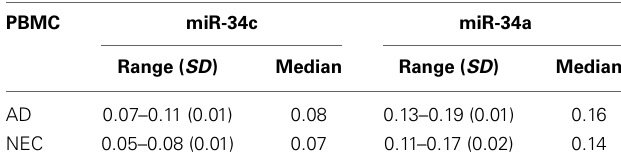
Table 6 | 1/deltaCt level ranges, with standard deviation (SD) and median, of microRNAs in PBMC from Alzheimer’s disease (AD) patients and age-matched normal elderly controls (NEC), for miR-34c and